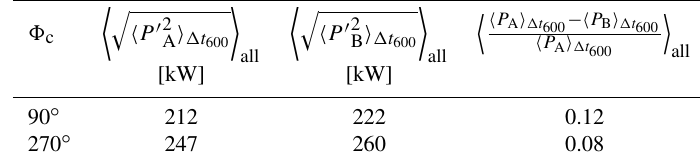
Table 2. Averaged wind turbine statistics computed for the wind direction intervals around 90 and 270 ◦ with A as the upstream wind turbine (cid:113) (cid:104) P (cid:48) 2 (cid:105) (cid:49)t is the standard deviation of the power output fluctuations of wind turbine A over 600s and B as the downstream wind turbine. A 600 intervals (cid:49)t 600 (analogue for wind turbine B for the same 600s intervals, respectively). (cid:104) P A (cid:105) (cid:49)t and (cid:104) P B (cid:105) (cid:49)t are the average power of 600 600 wind turbines A and B over the same 600s intervals. (cid:104) ... (cid:105) all denotes the average of the statistics over all available time intervals of the wind turbine pairs. Note that (cid:56) c depicts the centre of 20 ◦ wind direction intervals, here from 80 to 100 ◦ and from 260 to 280 ◦ .